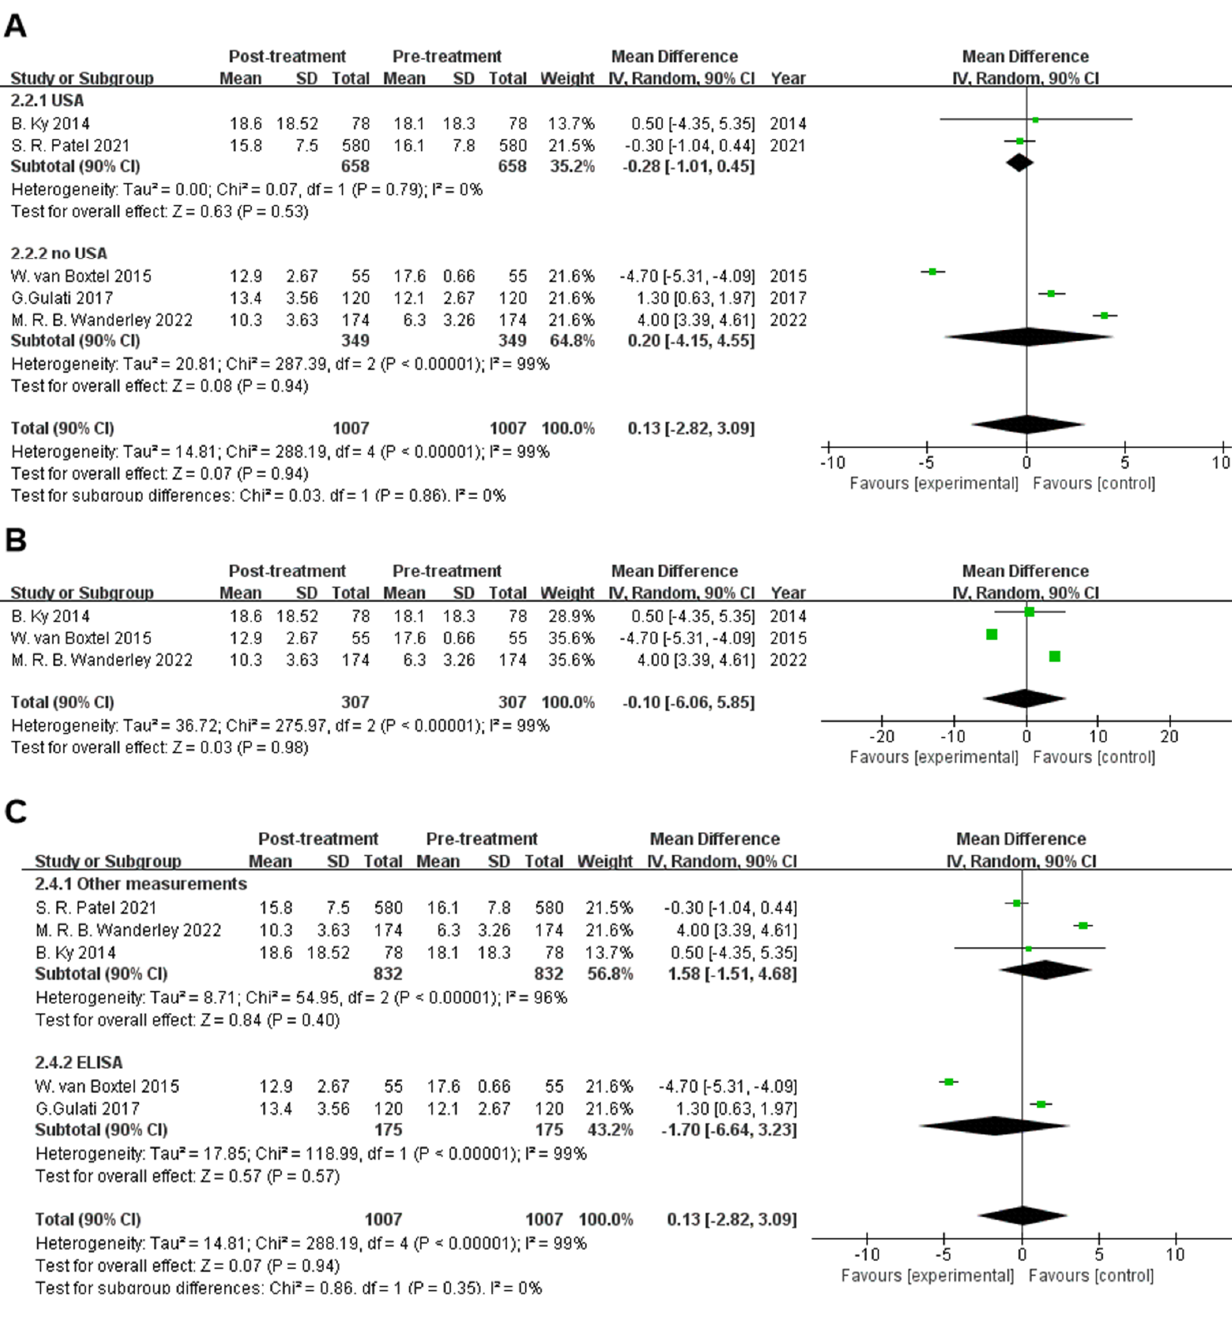
Figure 3. Overall and individual study estimates of the weighted mean difference of Galectin-3 are shown in patients receiving cancer treatment. Parallelogram boxes for weighted mean difference and horizontal lines represent 90% confidence interval (CI). Subgroup analyses were carried out independently for country ( A ), the presence of doxorubicin ( B ) and measurement ( C ) [14,15,17–19]. Subgroup analyses were performed independently for the country, the presence or absence of doxorubicin and the type of assay due to significant heterogeneity (I 2 : 99%). Two studies [14,19] included data from the USA, whereas the remaining three used data from the Netherlands, Norway, and Brazil. As a result, groups of patients from the USA and not from the USA (Figure 3A) were included in the subgroup analysis. The USA pop- ulation data showed no statistically significant difference in galectin-3 levels before and after treatment [USA WMD, −0.28 (90% CI −1.01, 0.45), I 2 : 0%, p = 0.79]; however, it is note- worthy that the USA group data were homogeneous. Population data from patients not living in the USA also showed no statistically significant difference [not living in the USA, WMD −0.20 (90% CI −4.15, 4.55), I 2 : 99%, p < 0.00001]. The subgroup analysis was per- formed based on the presence or absence of doxorubicin use. Doxorubicin was clearly used in three studies [15,17,19]; hence, a separate meta-analysis (Figure 3B) was per- formed for these three studies. The results indicate that galectin-3 levels did not statisti- cally change before or after doxorubicin treatment [WMD −0.10 (90% CI −6.06, 5.85), I 2 : 99%, p < 0.00001]. Regarding the type of assay, two studies [15,18] used the same meas- urement technique, namely, enzyme-linked immunosorbent assay (ELISA), whereas the remaining investigations employed various approaches. Based on our subgroup analysis (Figure 3C), we discovered that the heterogeneity between the two studies employing the same methodology remained significant (I 2 : 96%, p < 0.00001), indicating that the use of various measuring techniques in this investigation was not the primary cause of hetero- geneity. In this meta-analysis, heterogeneity was unavoidable but was reduced using a mul- tipathway analysis with a subgroup analysis based on the country where the study was performed. On the one hand, data heterogeneity persisted after subgroup analyses, so the use of subgroup analysis as a method to identify the reasons for the considerable hetero- geneity was unsuccessful. On the other hand, as observed from the findings of the studies that were included, the outcomes differed. Specifically, the results of three studies [17–19] that were included revealed an increase in galectin-3 levels after treatment, and two stud- ies [14,15] showed the opposite effect.